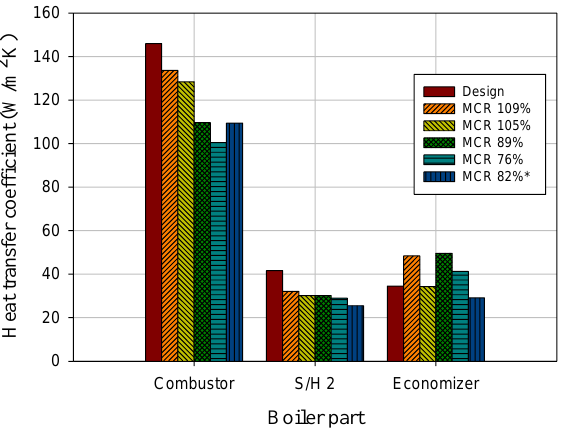
Figure 9. Heat transfer coefficient of boiler parts. (* After additional evaporator installation).